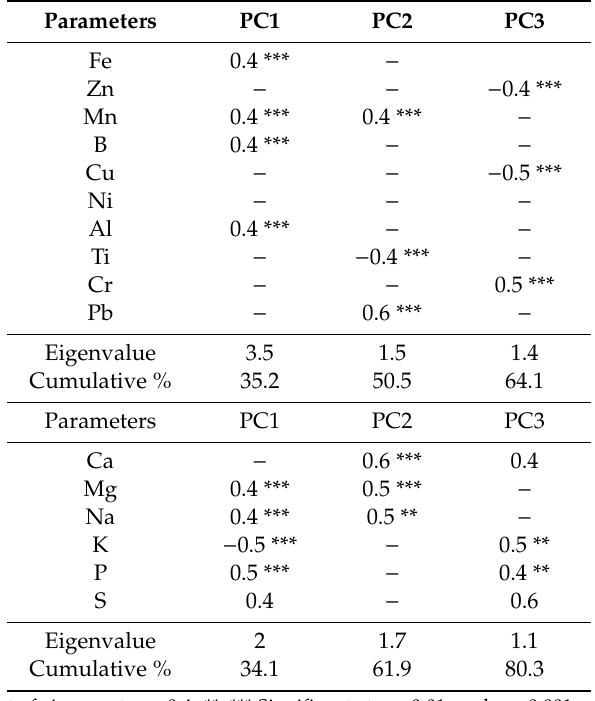
Table 6. Eigenvectors of the first three axes of the principal components (PC) analysis of the trace and macro elements of yellow-fleshed cassava roots